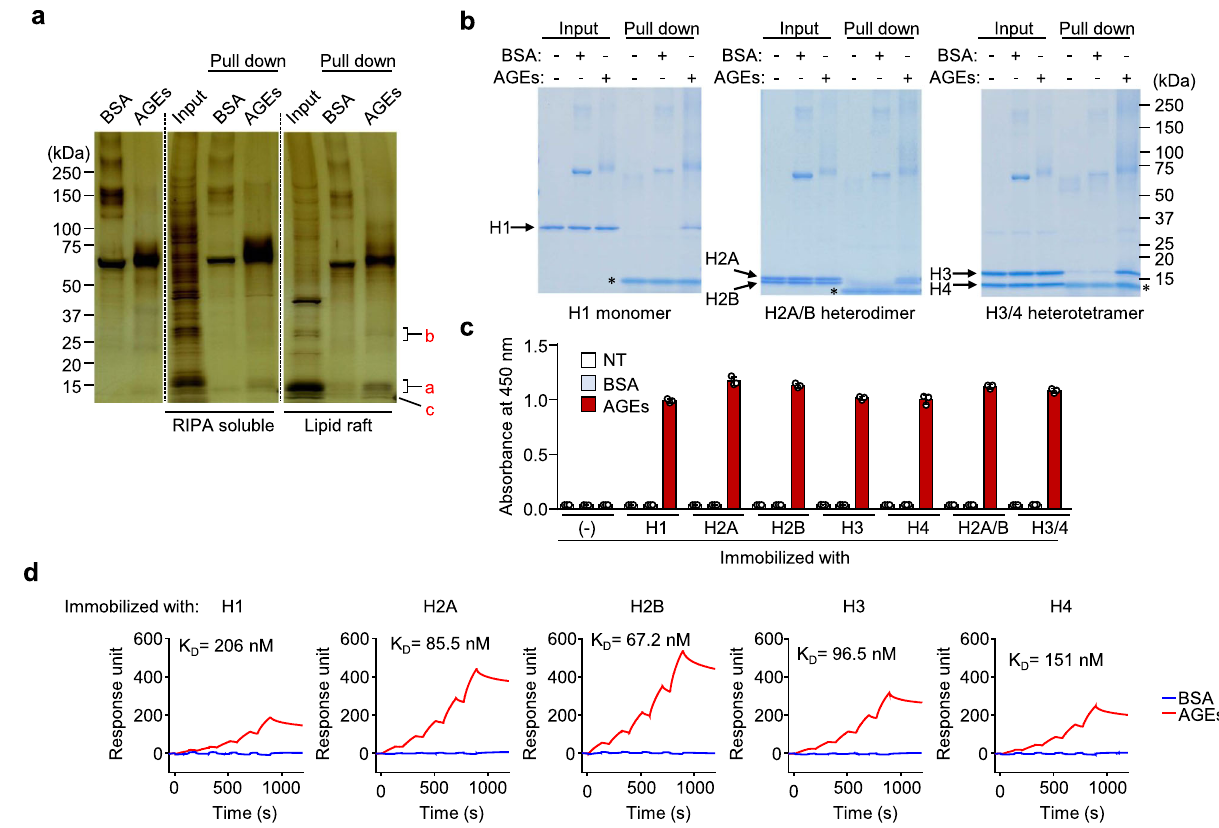
Fig. 1 Identi fi cation of a cell-surface binding protein for AGEs. a Pull-down assay for the detection of cell-surface AGEs-binding proteins. Both Bt-BSA or Bt-AGEs were incubated with proteins in RIPA-soluble or lipid raft fractions prepared from mouse splenocytes and subjected to pull-down assay with streptavidin-conjugated magnetic beads (Dynabeads). Binding proteins were separated by SDS-PAGE and detected by a silver staining method. Representative image of three independent experiments. b Pull-down assay for the binding of AGEs with the recombinant histone proteins. Recombinant histones (H1 monomer, H2A/B heterodimer, and H3/4 heterotetramer) incubated with Bt-BSA or Bt-AGEs were subjected to pull-down assay with streptavidin-conjugated magnetic beads. Pulled-down proteins were separated by SDS-PAGE, and gels were stained with CBB. The asterisk (*) represents nonspeci fi c bands. c Binding of AGEs to the recombinant histones. Recombinant histones immobilized on ELISA plate were incubated with Bt-BSA or Bt- AGEs (5 µ g/ml). The binding was detected using streptavidin-HRP. Data are mean ± S.D. of triplicate samples and are representative of three